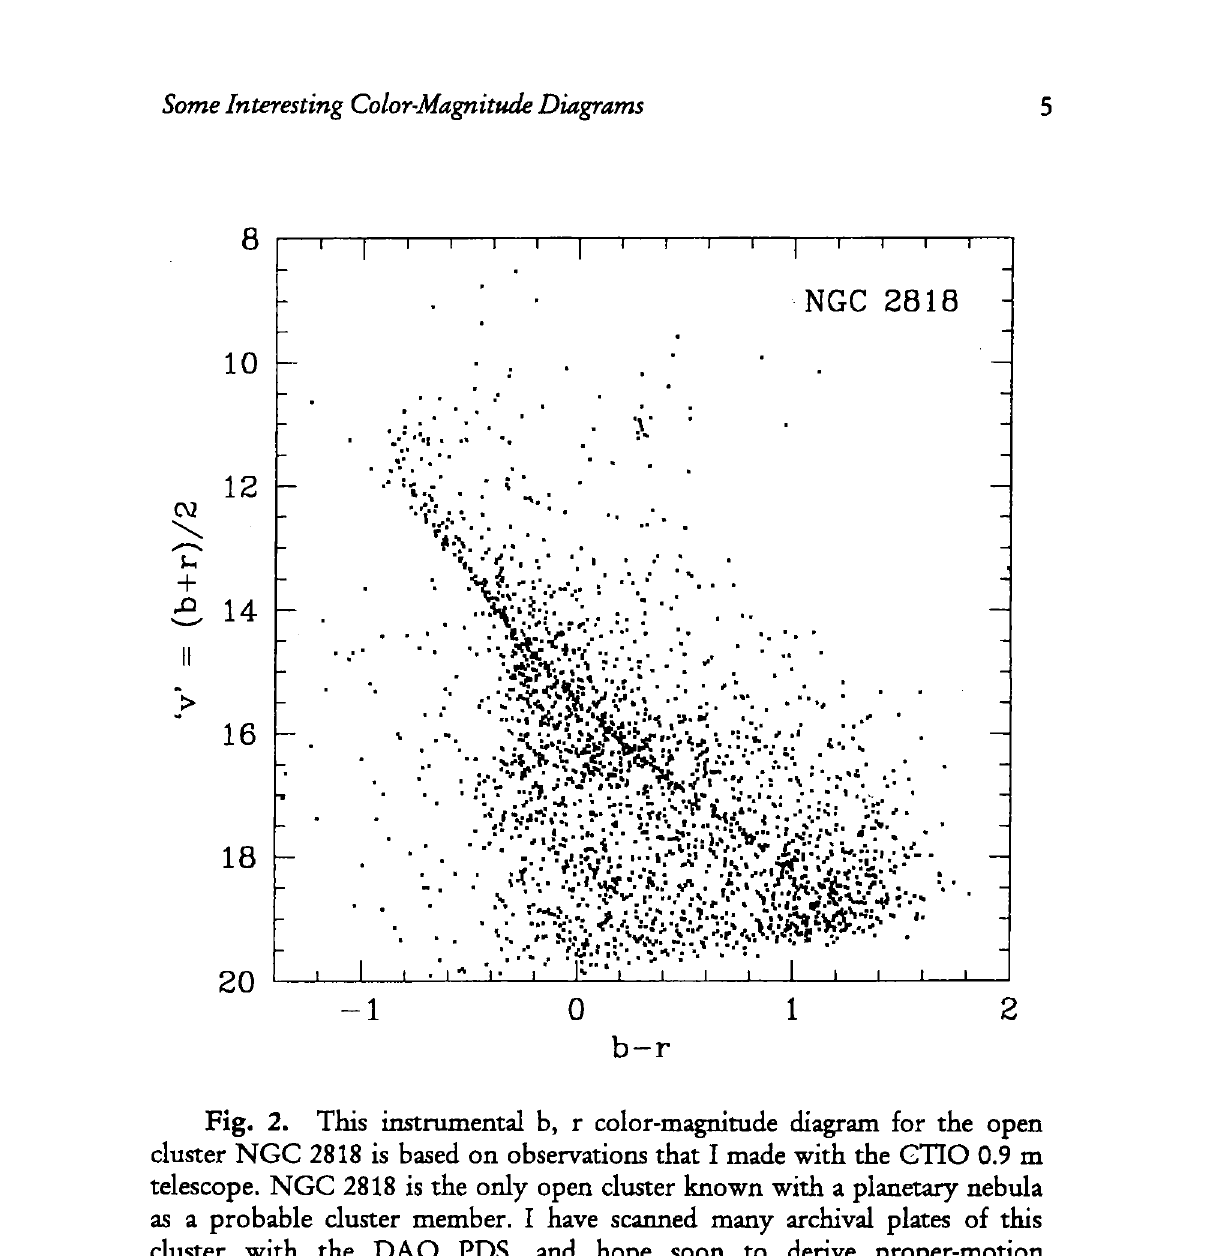
Fig. 2. This instrumental b, r color-magnitude diagram for the open cluster NGC 2818 is based on observations that I made with the GTIO 0.9 m telescope. NGC 2818 is the only open cluster known with a planetary nebula as a probable cluster member. I have scanned many archival plates of this cluster with the DAO PDS, and hope soon to derive proper-motion probabilities that will help to distinguish between true cluster members and fore- and background disk stars. An improved estimate of the cluster distance and turnoff mass should help constrain models of planetary